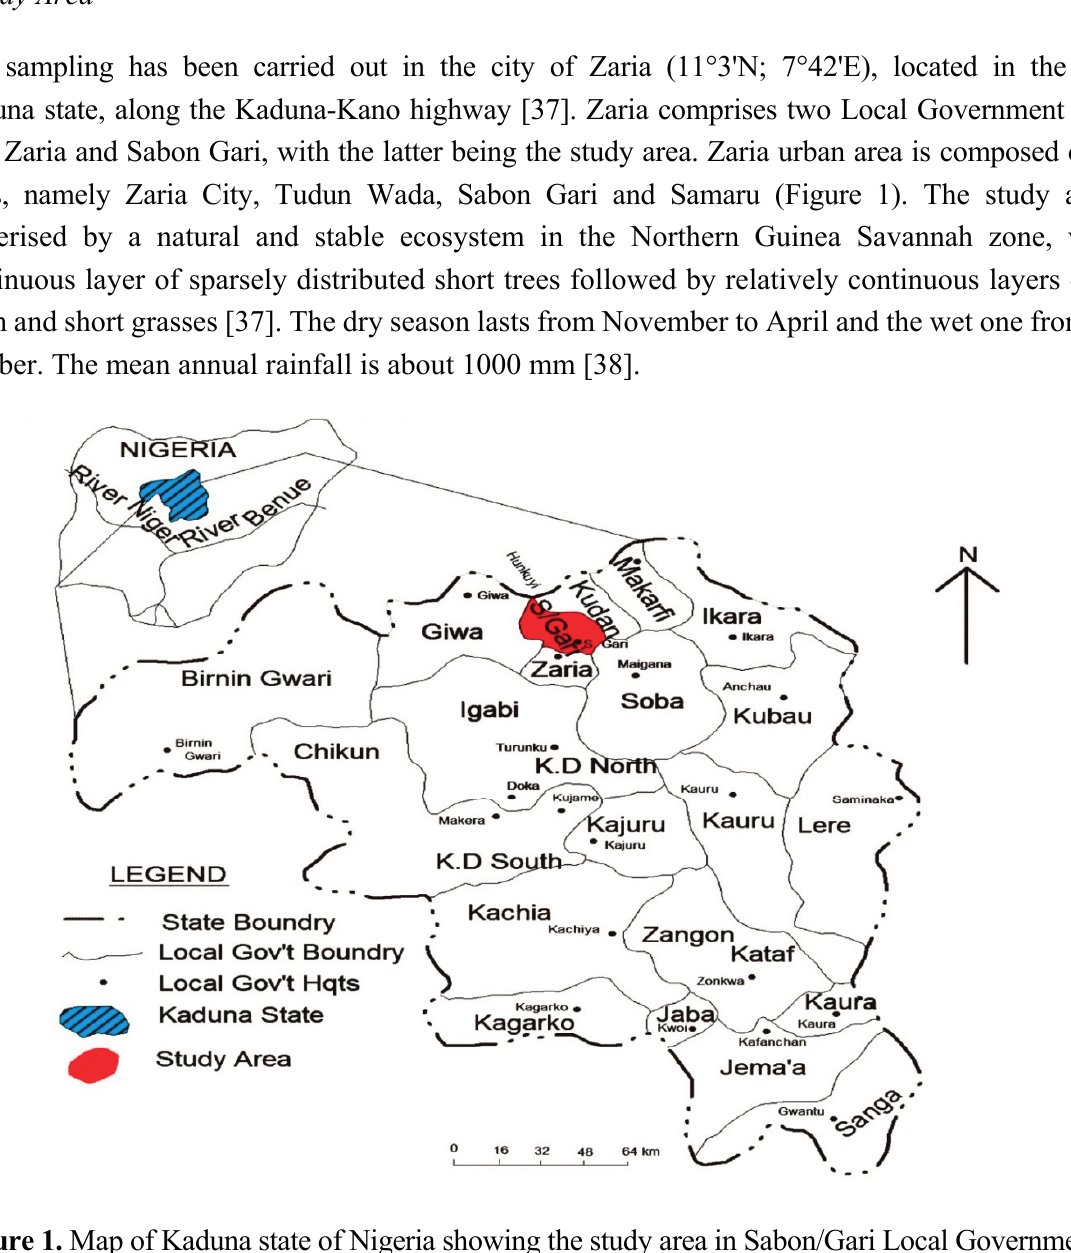
Figure 1. Map of Kaduna state of Nigeria showing the study area in Sabon/Gari Local